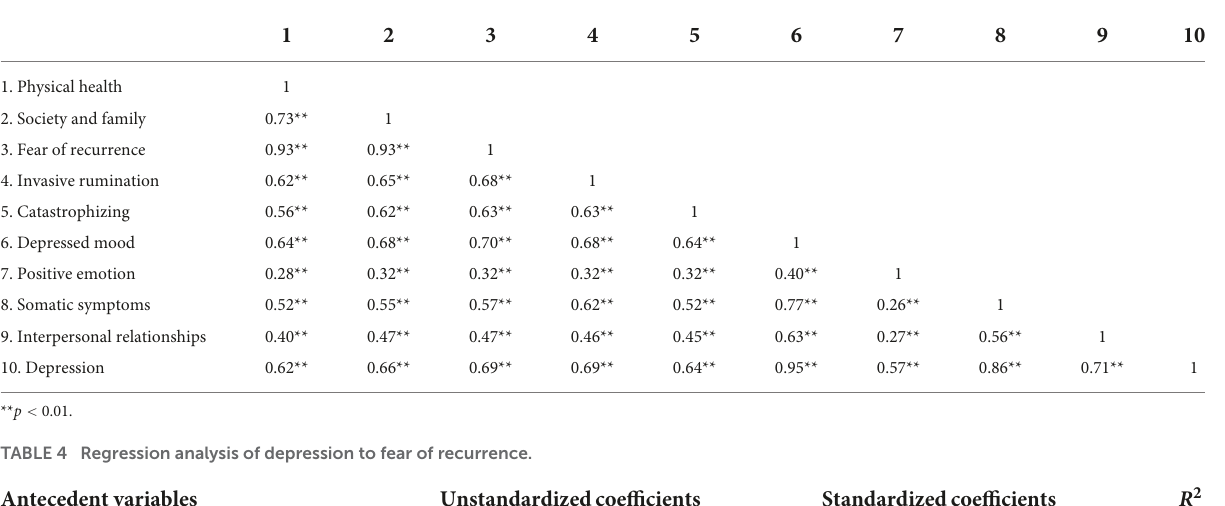
TABLE 3 Correlation coefficients of fear of recurrence, invasive rumination, catastrophizing, and depression.